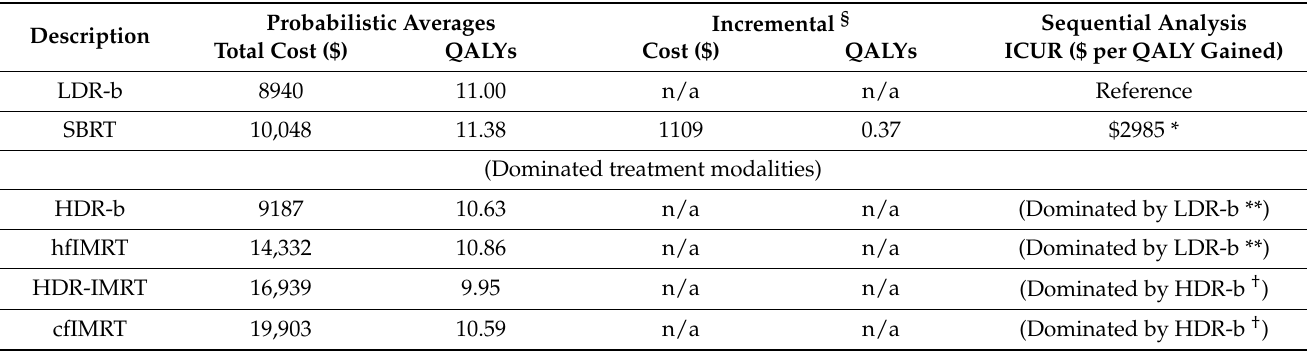
Table 1. Cost-effectiveness for radiation treatment